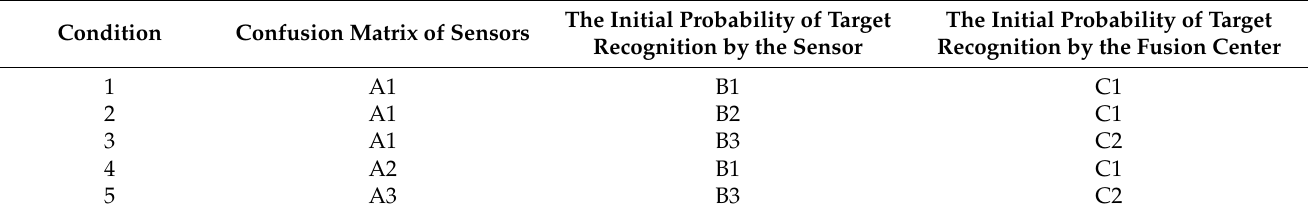
Table 3. Simulation settings of parameters.